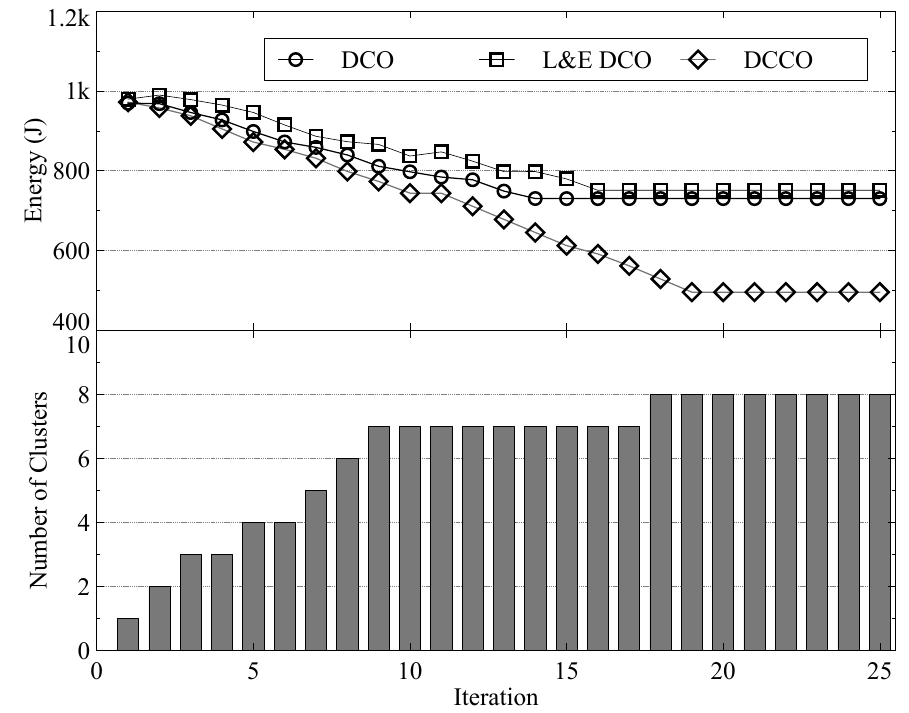
Figure 8. The convergence performance with 30